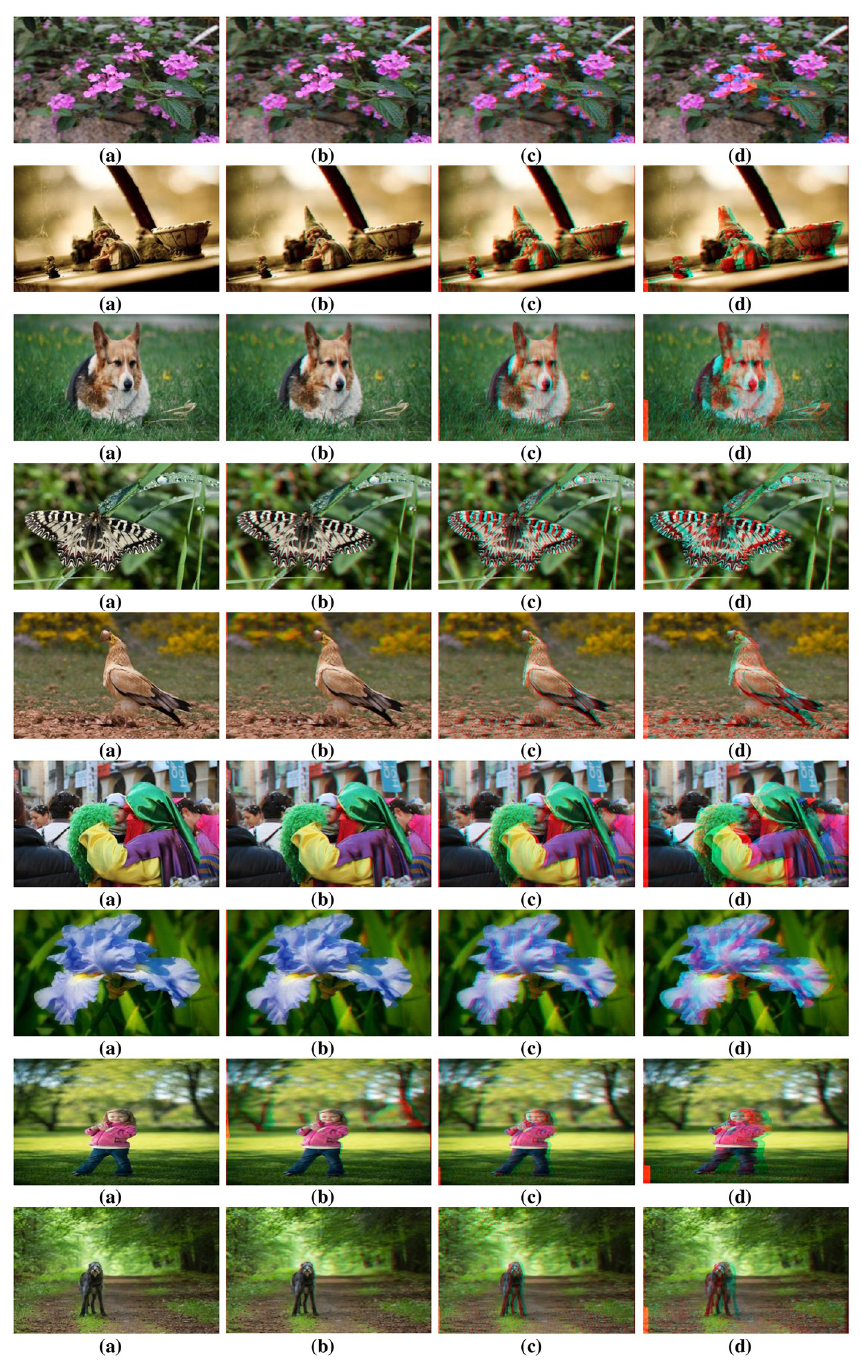
Fig 14. Anaglyph results of dataset [38]. ( a ) Input Images ( b ) Anaglyph produced by Zhuo.et al. [12] ( c ) Anaglyph produced by Yang.et.al. [26] and ( d ) Anaglyph generated by DFB-DIBR.